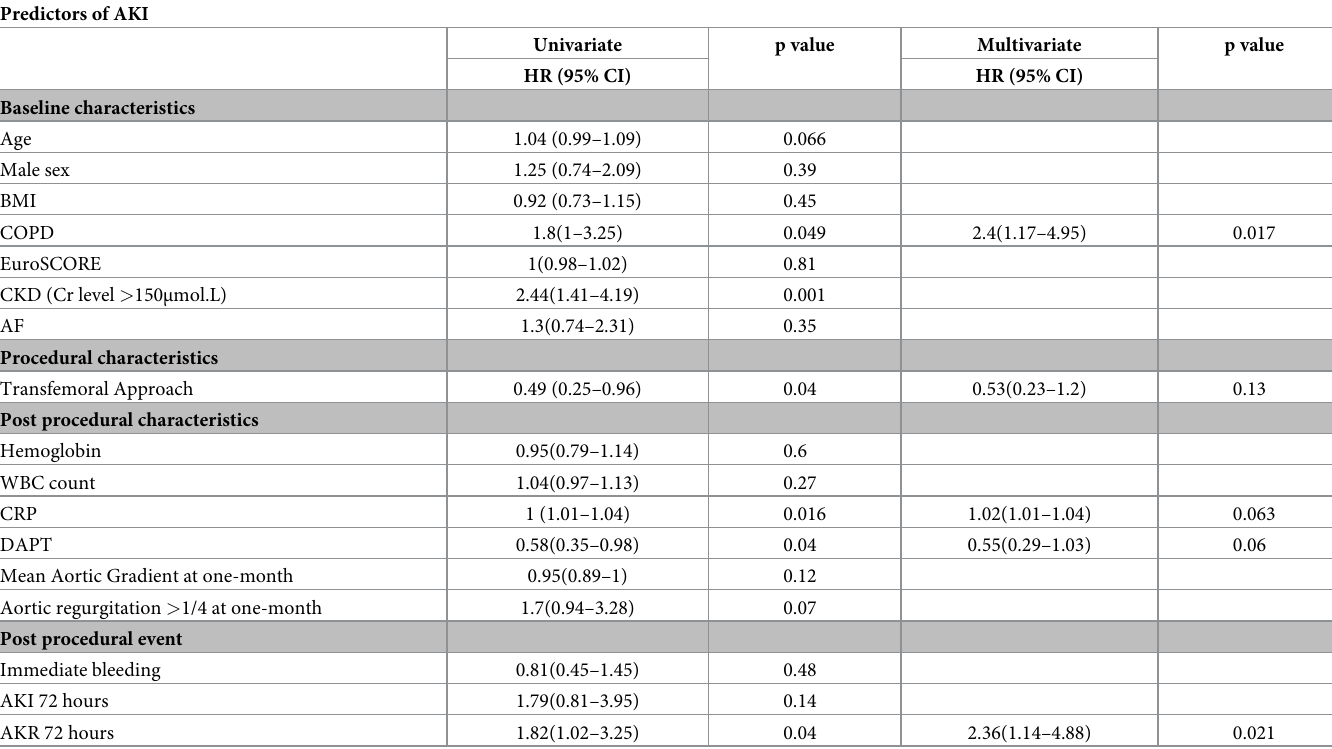
Table 7. Predictors of cardiovascular